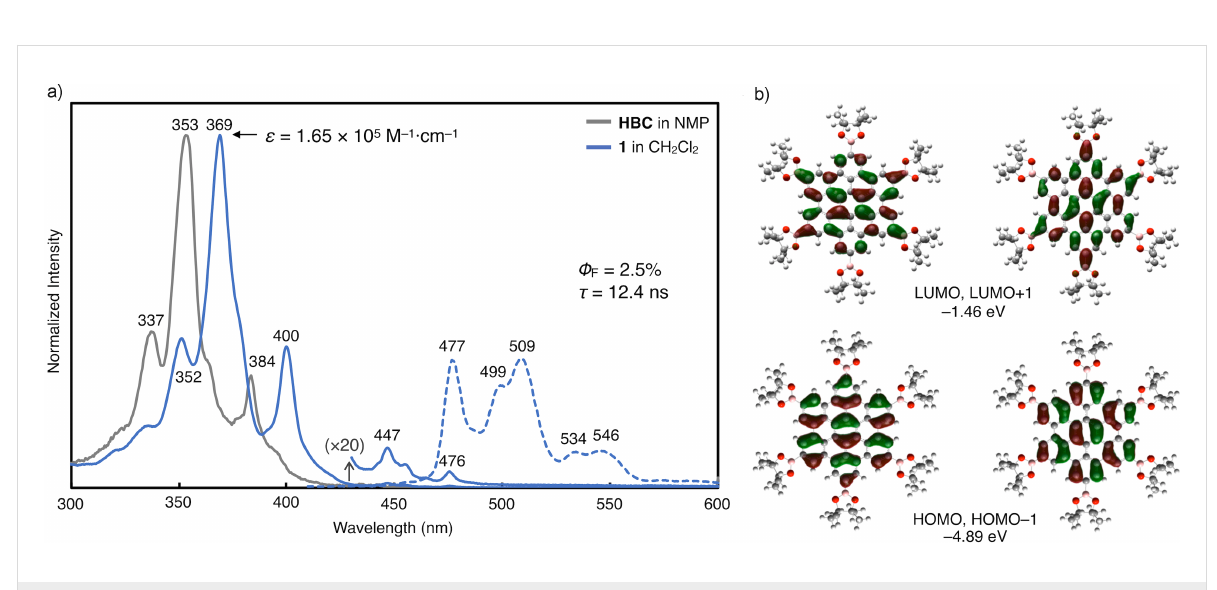
Figure 4: Photophysical properties of 1 . (a) UV–vis absorption (solid lines) spectra, fluorescence (dotted line) spectrum, absolute fluorescence quan- tum yield ( Φ F ) and fluorescence lifetime ( τ ). (b) Frontier molecular orbitals and energy levels of 1 calculated at the B3LYP/6-31G(d) level of theory.